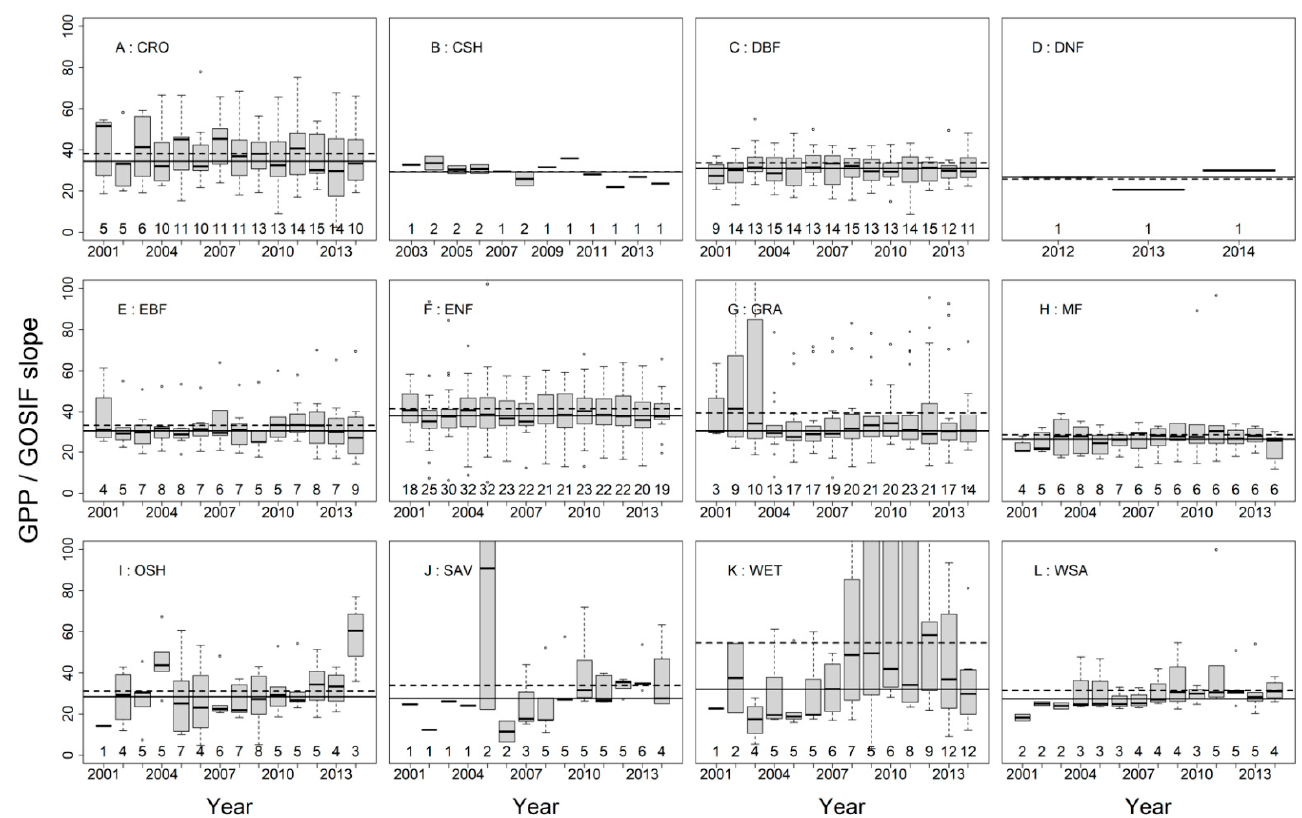
Figure 5. Interannual variability of the slopes between GOSIF and GPP across 12 biomes. The explanation of the boxplot symbols is given in Figure 4.